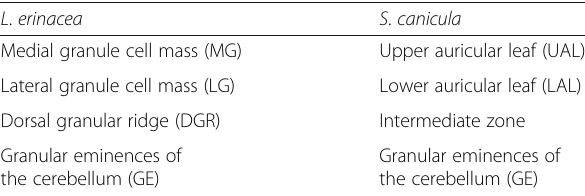
Table 2 Terminology of corresponding granule cell masses between L . erinacea and S . canicula